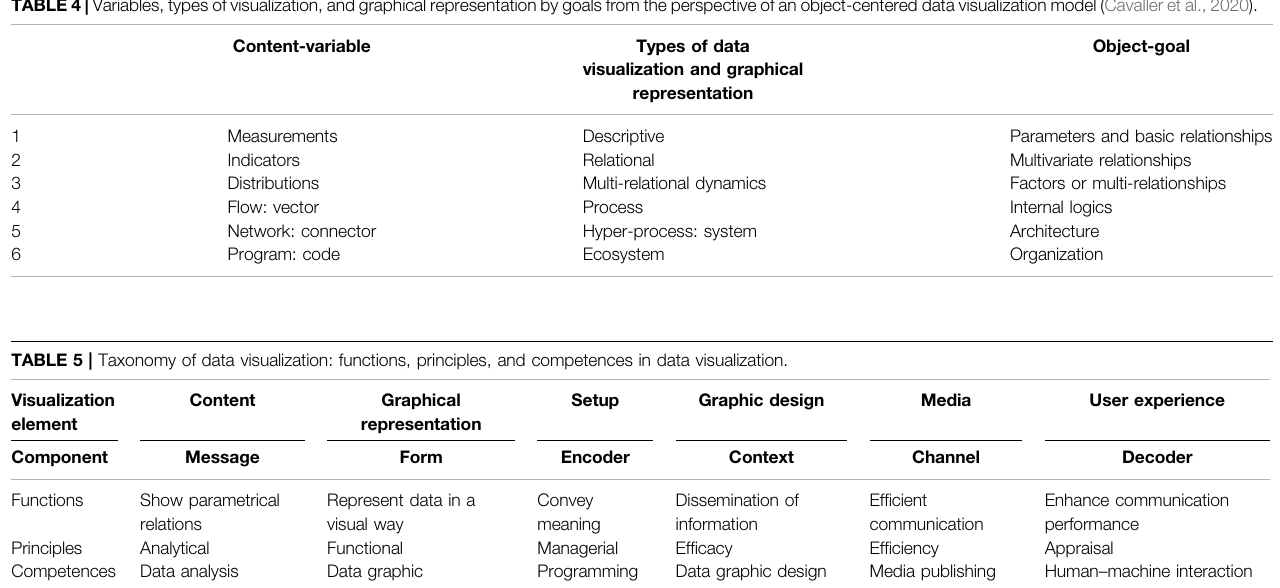
TABLE 4 | Variables, types of visualization, and graphical representation by goals from the perspective of an object-centered data visualization model (Cavaller et al., 2020).